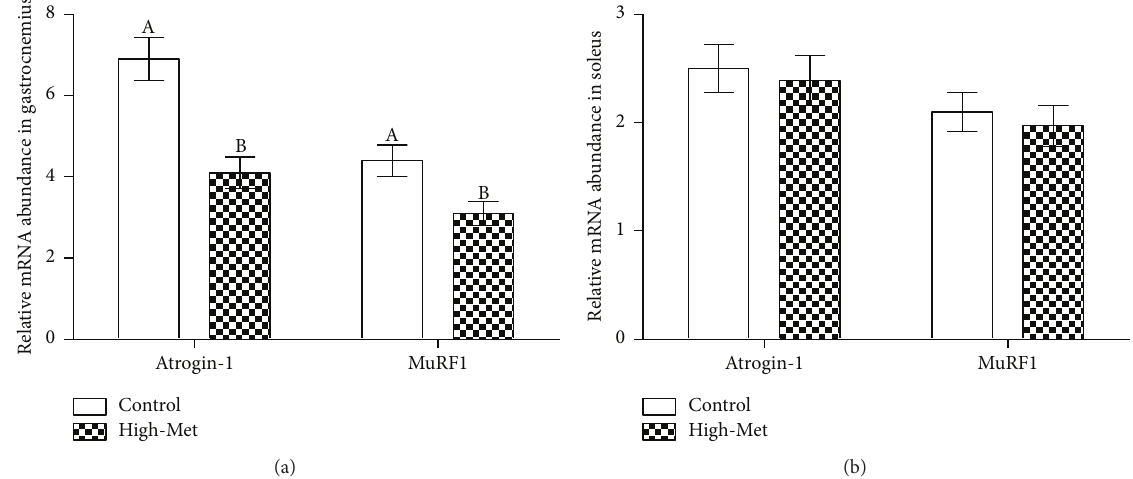
Figure 3: Results of high-Met diet upon the level of mRNA in gastrocnemius (a) and soleus (b). Data is presented as means ± SEM ( 𝑛 = 8 ). A , B The varying characters indicate the statistically significant differences between the high-Met and control groups ( P < 0.05).